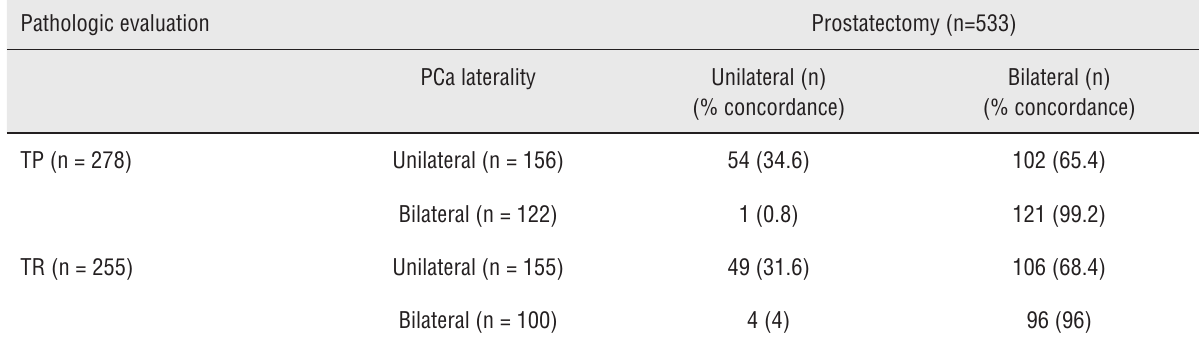
Table 2 - Agreement between biopsy and prostatectomy in terms of tumor laterality. Pathologic